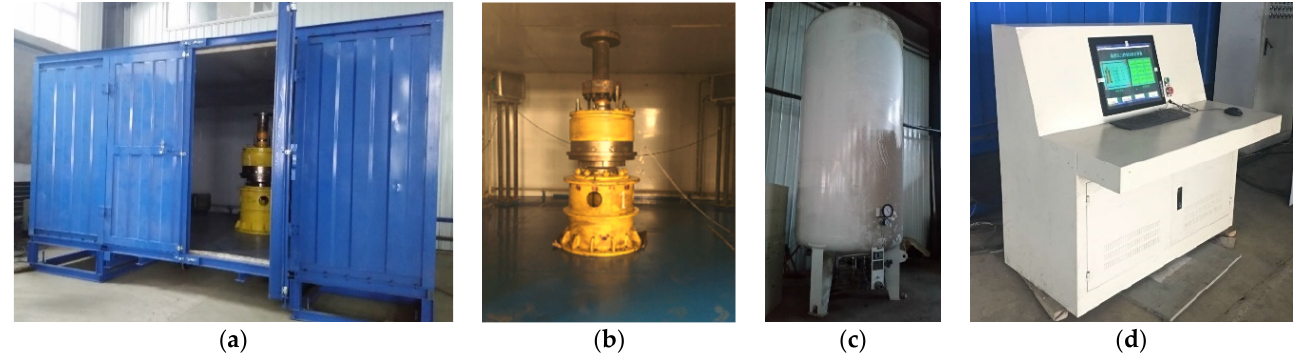
Figure 11. Device of temperature cycle test. ( a ) Temperature cycle test box; ( b ) connector and connection line; ( c ) liquid nitrogen container; ( d ) console station.